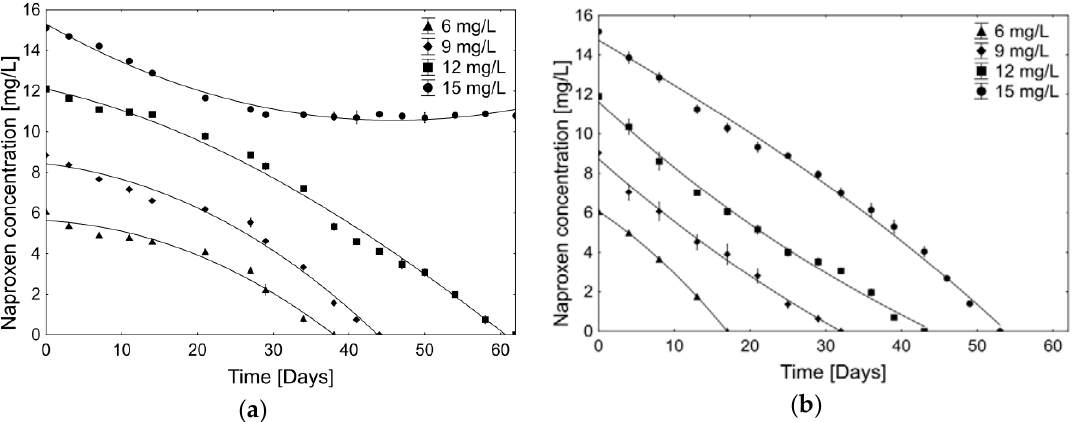
Figure 2. Cometabolic degradation of 6, 9, 12 and 15 mg/L naproxen by ( a ) free cells of Planococcus sp. S5; ( b ) cells of Planococcus sp. S5 immobilized onto the loofah sponge. Data presented as mean ± standard deviation of three replicates.